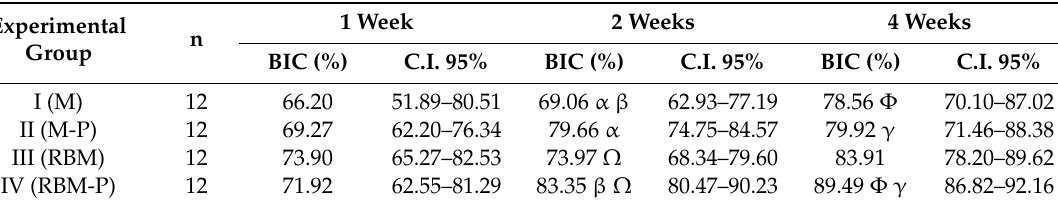
Image 2. Histological preparations at one, two, and four weeks after implant placement. Graphic 2. BIC percentages with the C.I. (95%) of each experimental group obtained by histological evaluation at one, two, and four weeks. p values= (α) 0.018; (β) 0.001; (Ω) 0.035; (Φ) 0.018; (γ) 0.024.